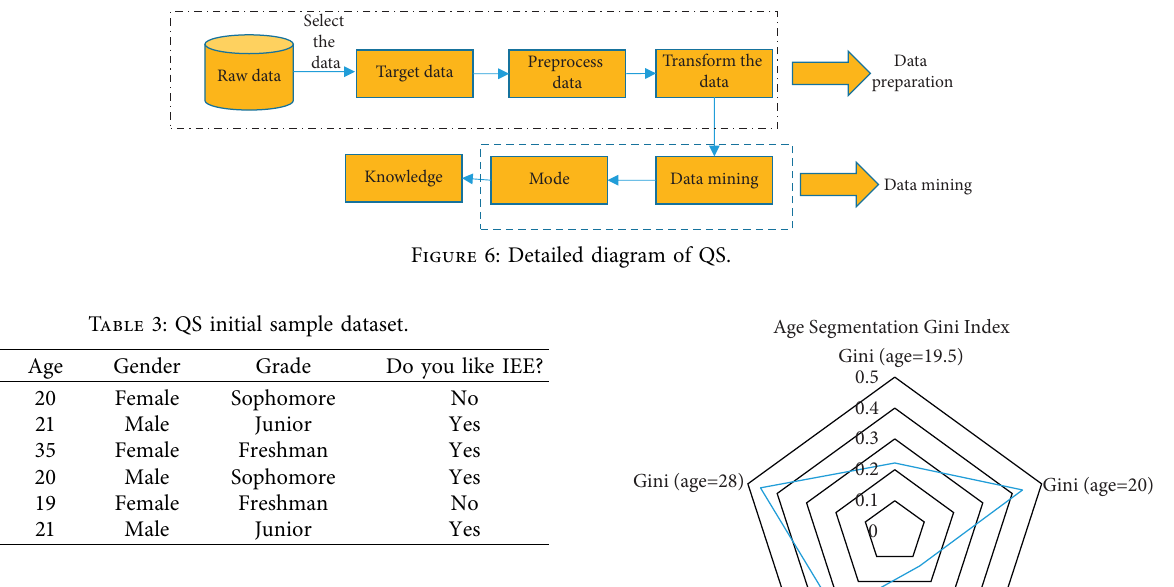
Table 4: Age attribute list.